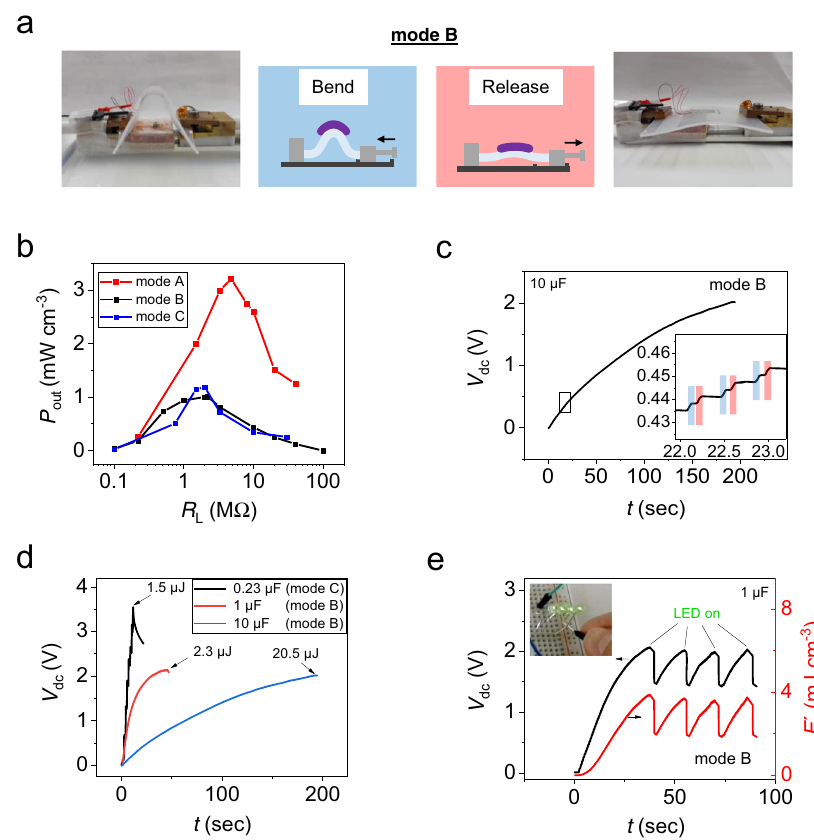
Fig. 7 Energy harvesting. Harvesting of actuation energy generated by periodic (2 Hz) bending and releasing of an UFPT placed on top of a 2-mm-thick rubber layer via sliding on a rail (mode B). a Photographs and schematics of the bending procedure. b The output power density P out of mode B is plotted as a function of load resistance R L (black curve) and compared to those from mode A (red curve) and mode C (blue curve). c Charging curve of a capacitor for an UFPT excited in mode B. The UFPT is connected to the ultrathin OFWR, which then charges the capacitor ( C = 10 µ F). The enlargement shows the generated energy steps related to bending (blue) and releasing (red) motions. d The capacitor voltages V dc plotted over time and the maximum stored C (cid:2) V 2 energy levels ( E ¼ 1 ) are shown for three different capacitor values, whereby the smallest capacitor with 0.23 µ F is an ultra fl exible thin- fi lm capacitor dc 2 fabricated on the 1- µ m thin parylene substrate. For charging the thin- fi lm capacitor, the UFPT was excited by bending mode C. Capacitors were charged almost to saturation. The maximum charging voltage depends on the generated energy of the PENGs (voltage levels), discharging effects and parasitic voltage drops along the energy harvesting circuits. e The time dependence of capacitor voltage V dc and of the energy density E ’ generated by periodically bending an UFPT and dissipating the energy by powering four LEDs that are connected in parallel. Table 1 Power output of UEHD for different energy-harvesting modes.